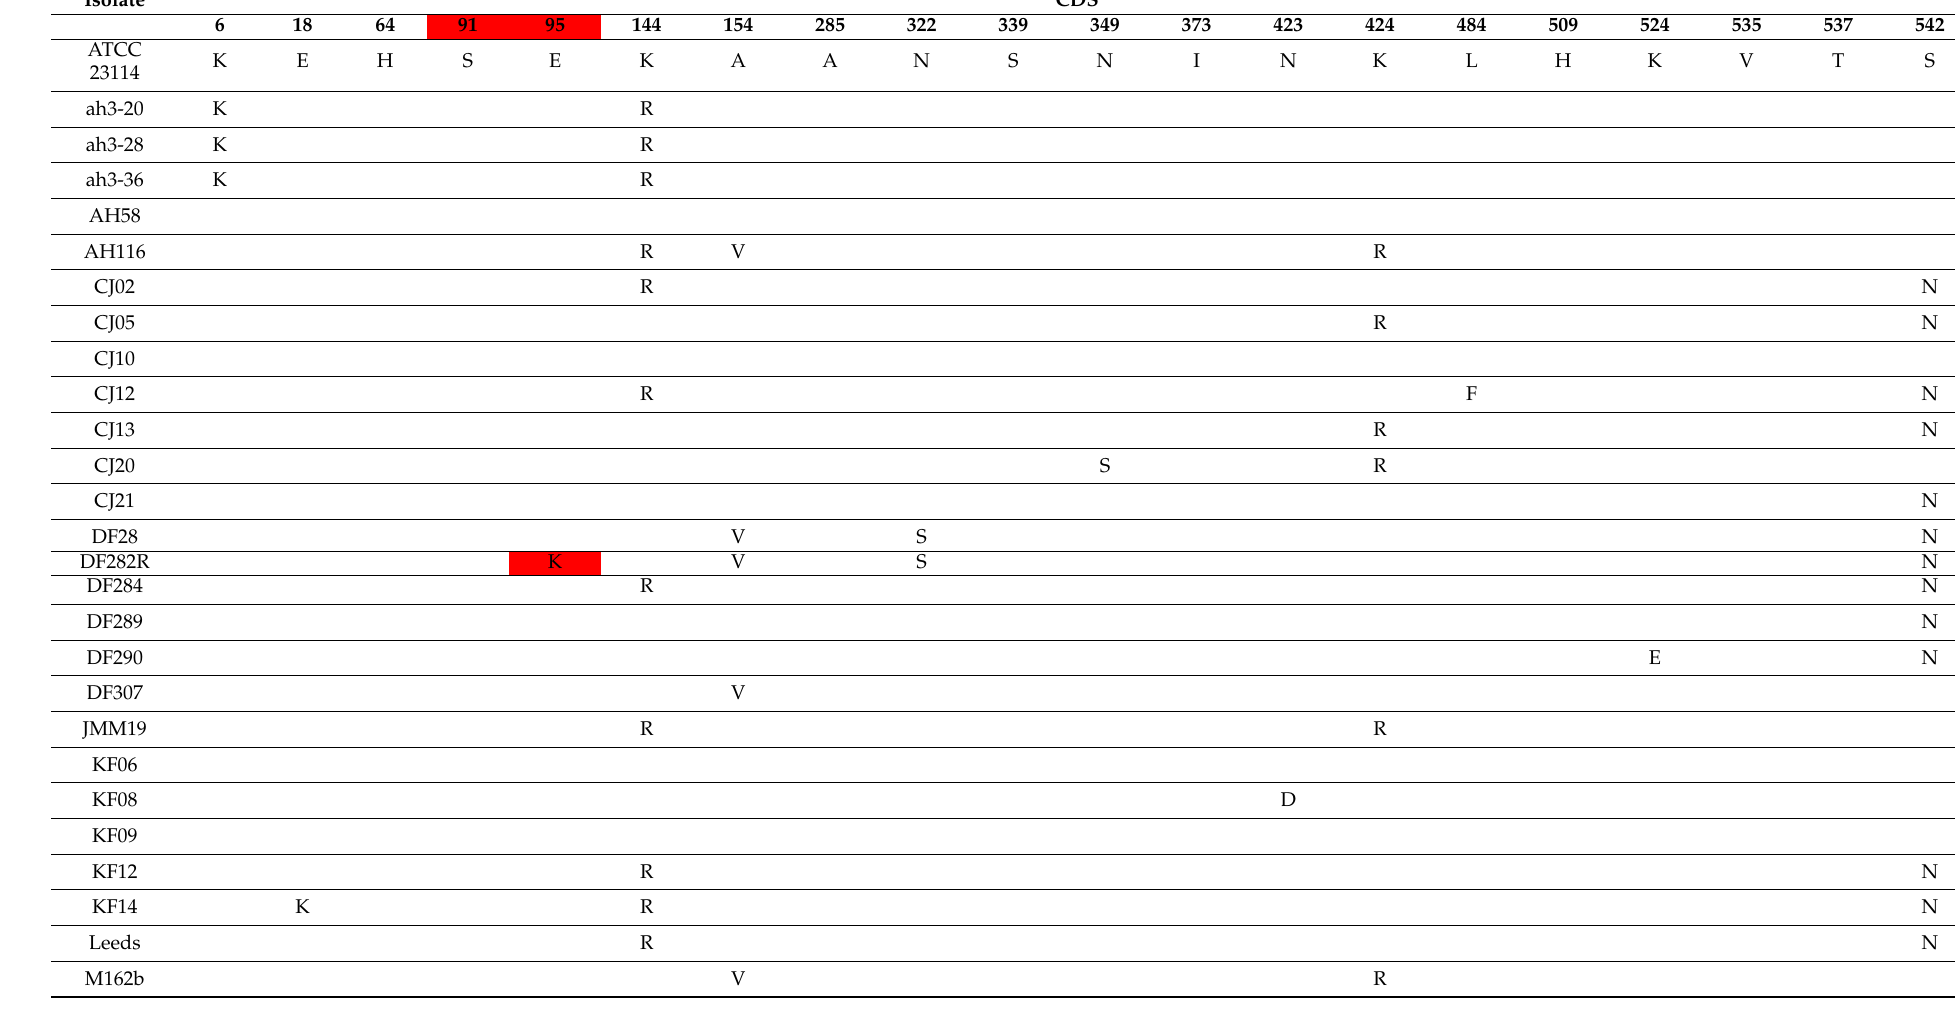
Table A3. Amino acid variations present in the parC genes of all isolates analyzed in reference to ATCC 21134. CDS numbers in the QRDR and associated mutations are highlighted in red.